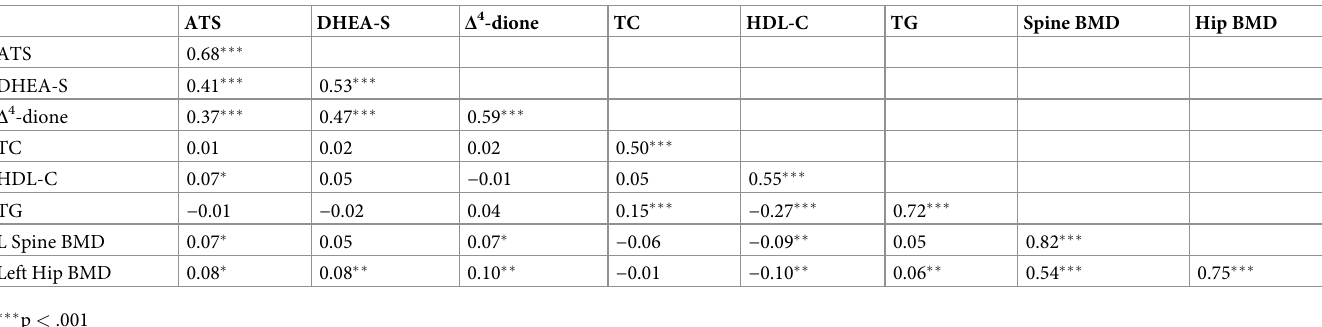
Table 2. Phenotypically standardized genetic variance